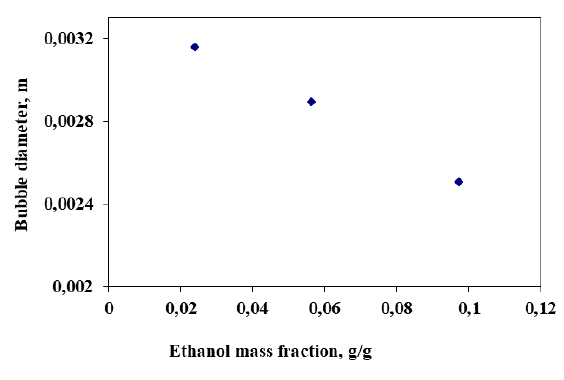
Figure 7: Changes in the bubble diameter by mixing different volumes of water-ethanol